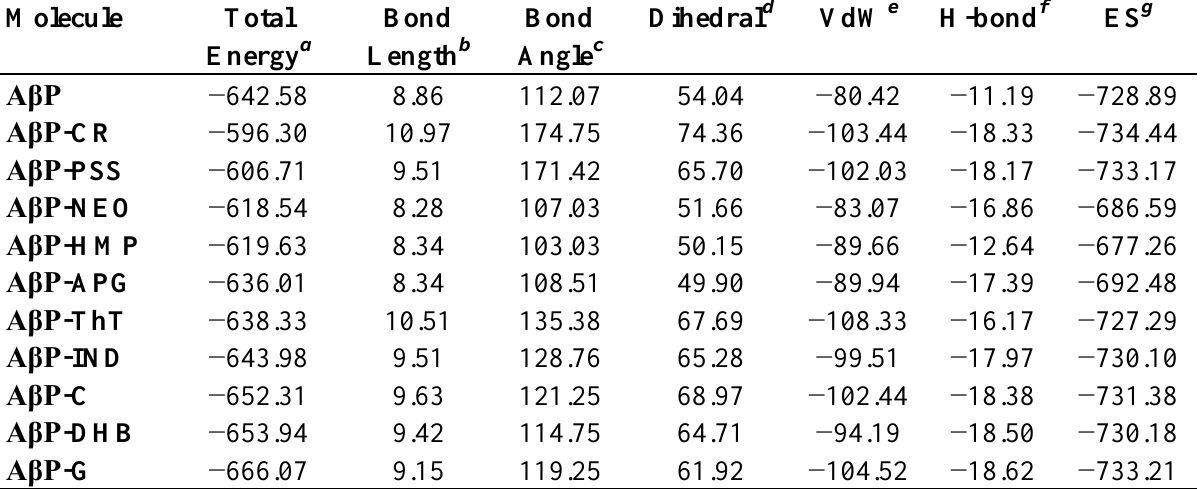
Table 1. Computed energy parameters (kcal/mol) of the protein-NE